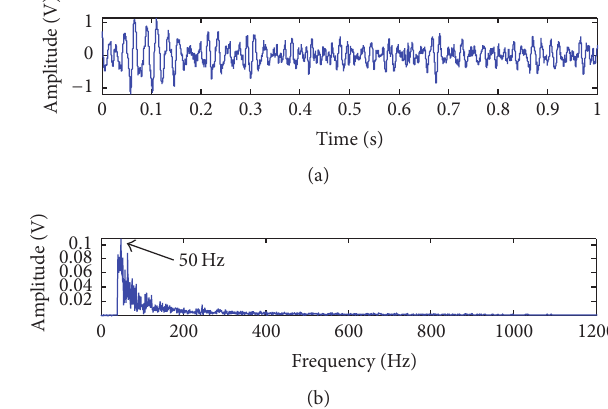
Figure 8: Optimal output signal of IMF2: (a) time-domain wave- form; (b) frequency spectrum.